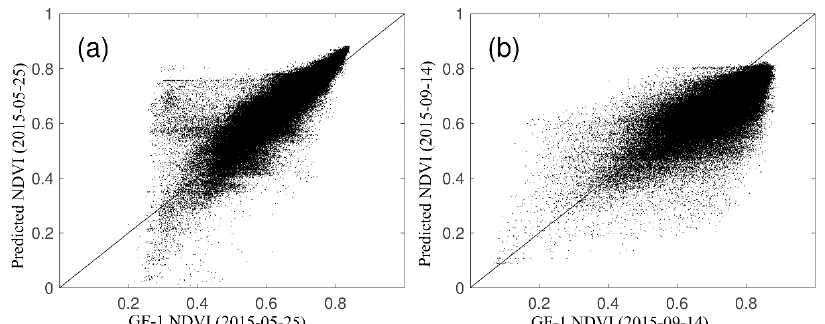
Figure 4. Scatterplots between values from the actual GF-1 NDVI images and the fused NDVI images (using STARFM) on the same date. ( a ) refers to data on 25 May 2015; ( b ) refers to data on 14 September 2015. Diagonal lines represent the line y = x .